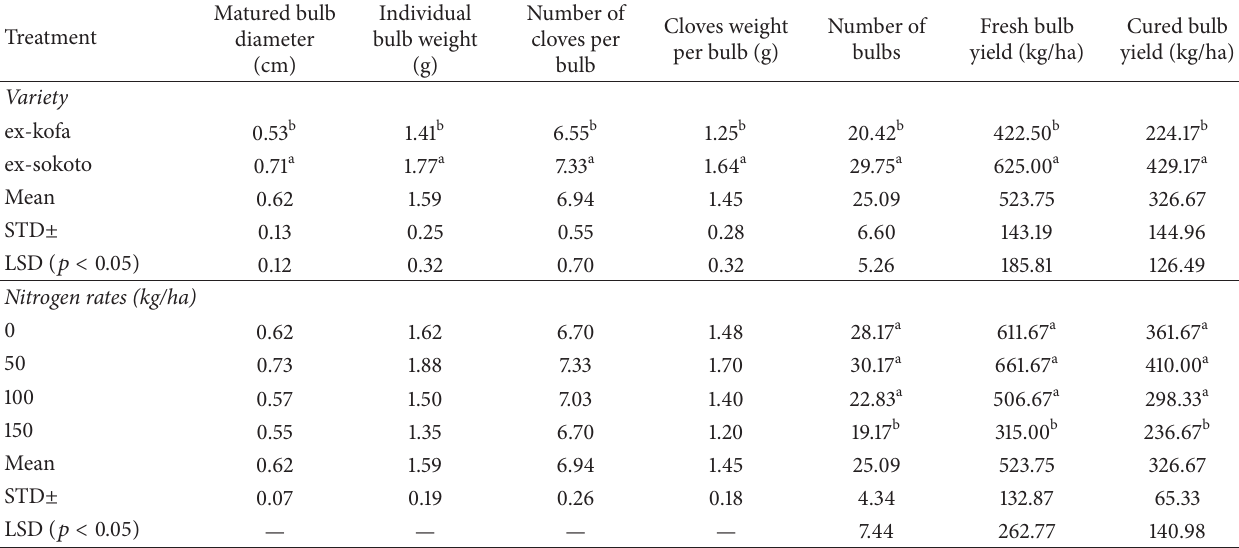
Table 2: Effect of variety and nitrogen rates on the yield and yield components of garlic during the 2010/2011 dry season at Ajiwa.